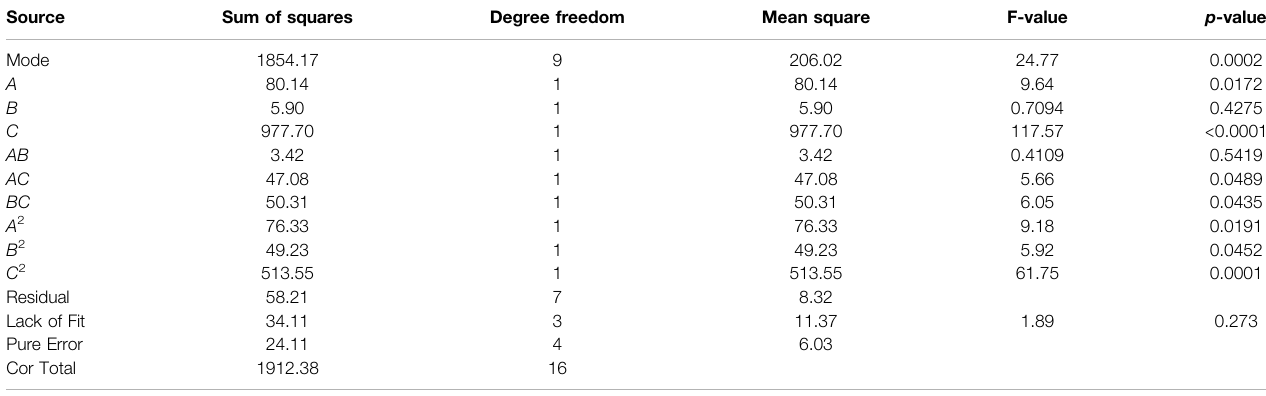
TABLE 3 | ANOVA for adsorption of